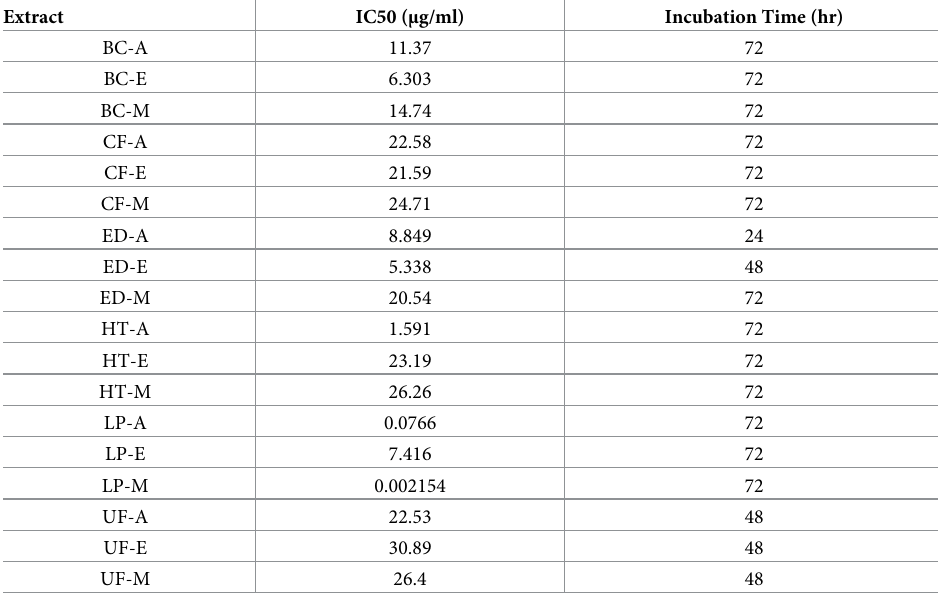
IC50 values of different lichen species extracts were evaluated based on non-cytotoxic concentrations and incubation times of each extract. BC: Bryoria capillaris , CF: Cladonia fimbriata , ED: Evernia divaricata , HT: Hypgminia tubulosa